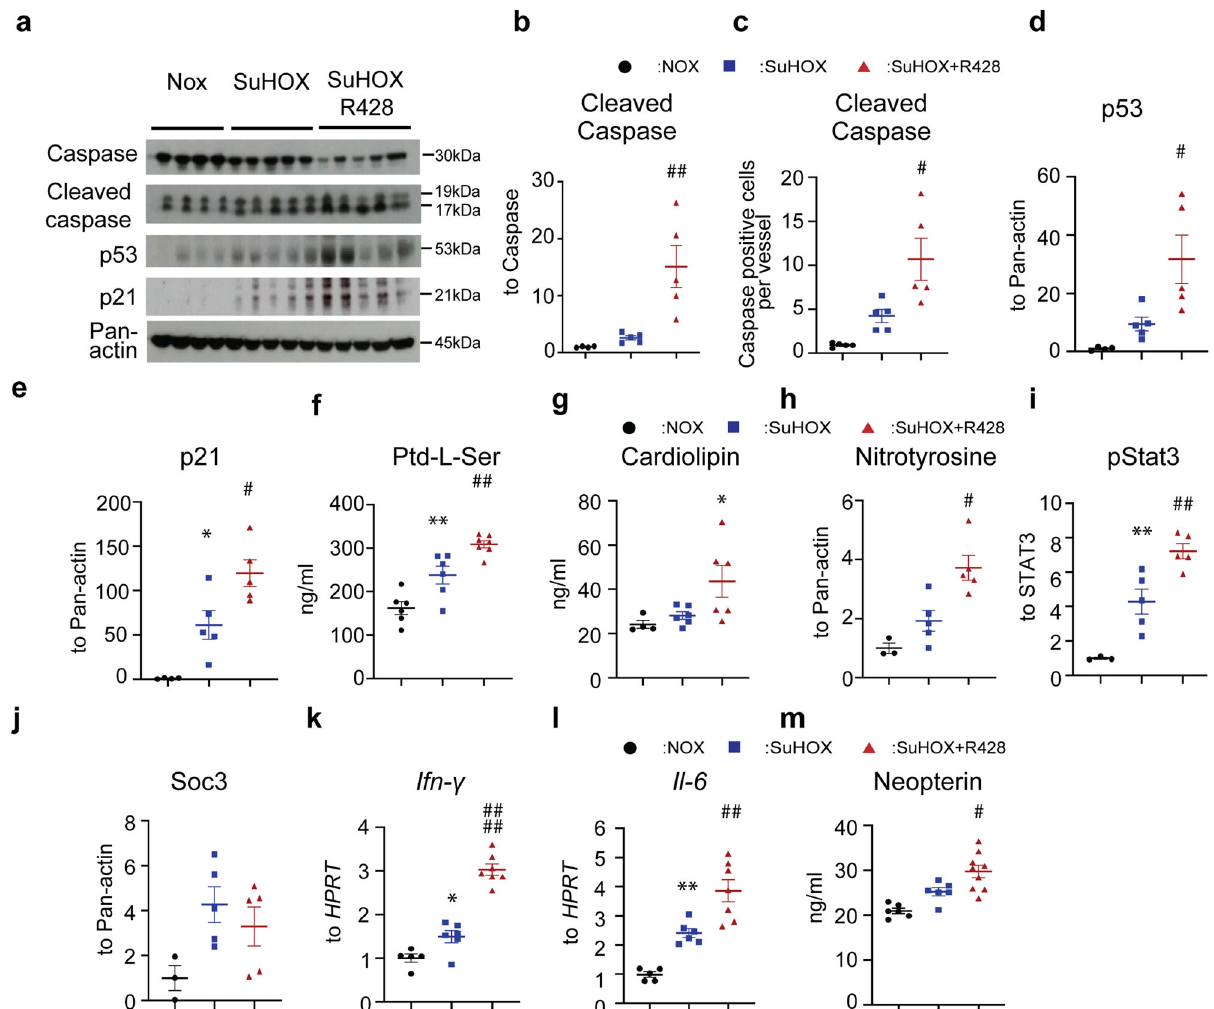
Fig. 4 Effect of R428 on apoptotic, in fl ammatory, and immune responses in the Sugen 5416/hypoxia (SuHOX) experimental rat model of pulmonary hypertension. a Representative western blots of markers of apoptosis. b Subsequent densitometric quanti fi cation of Cleaved Caspase. c Quantitative analyses of Caspase-positive cells per vessel. d , e Densitometric quanti fi cation of d p53 and e p21. f , g , m Enzyme-linked immunosorbent assay (ELISA) for analysis of the presence of phosphatidylserine (Ptd-L-Ser), anti-cardiolipin antibody IgG (ACA-IgG) and neopterin in plasma of rats. h – j Densitometric quanti fi cation of markers of in fl ammation h nitrotyrosine, i phosphorylated signal transducer and activator of transcription 3 [phospho-STAT3], and j suppressor of cytokine signaling 3 [SOCS3]) in total lung homogenates. k , l Real-time quantitative PCR analysis of k interferon γ ( Ifn- γ ) and l interleukin 6 ( Il-6 ) mRNA expression in lungs of rats. Data are presented as the n -fold change (2 − ΔΔ Ct ) normalized to hypoxanthine guanine phosphoribosyl transferase ( Hprt ) as a reference gene, compared with NOX. The numbers of biological independent rats included in the analyses were as follows. Western blots and densitometric quanti fi cation: normoxic rats (NOX), n = 4; SuHOX + placebo (SuHOX), n = 5; SuHOX + R428, n = 5. Real-time quantitative PCR: NOX, n